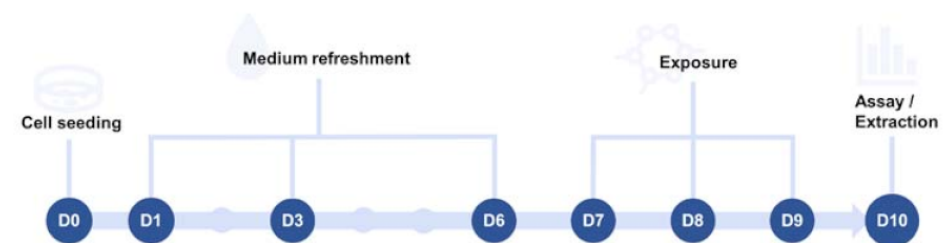
Figure 13. Treatment of cell cultures. The scheme provides an overview of every step in the cell culture